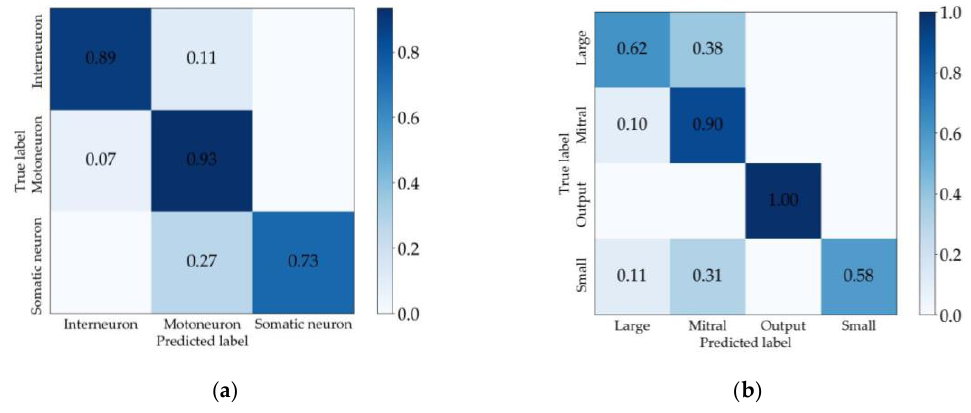
Figure 17. Confusion matrix of neuronal classification by LCCDNNs. ( a ) C. elegans dataset, ( b ) zebrafish dataset. Appl. Sci. 2019 , 9 , x FOR PEER REVIEW